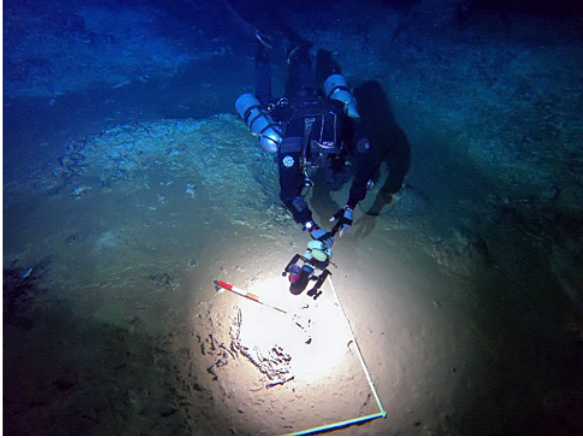
Figure 8 . The Keldan lighting during a photogrammetric